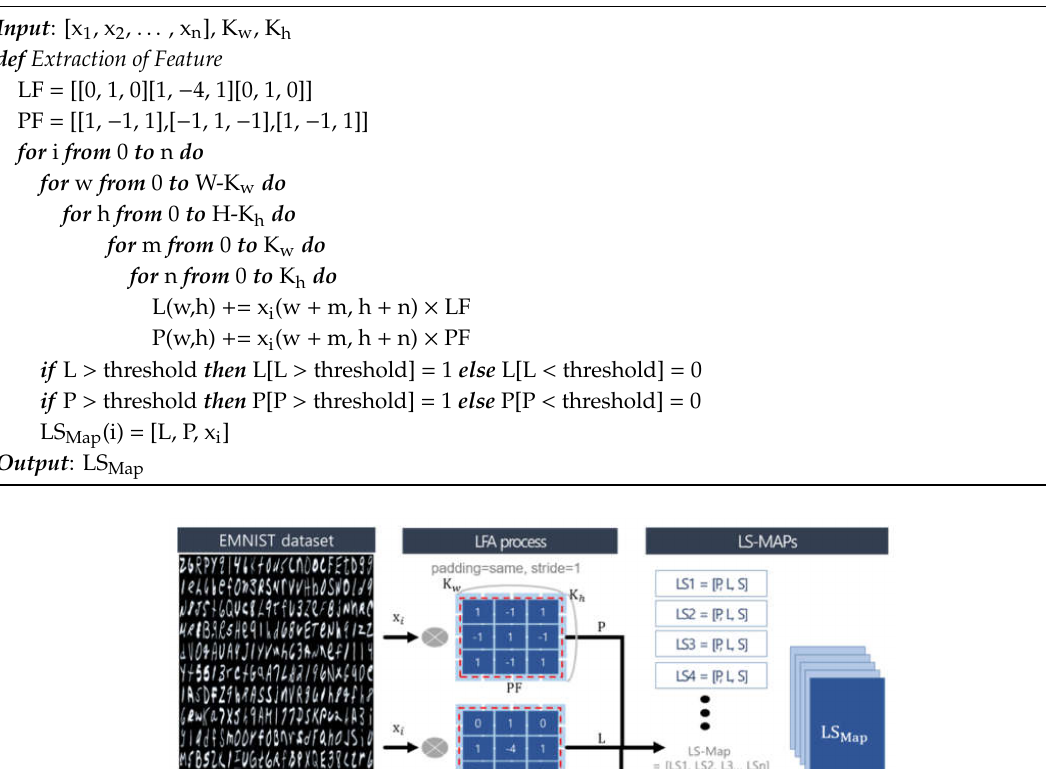
Algorithm 1: Feature Detection Algorithm